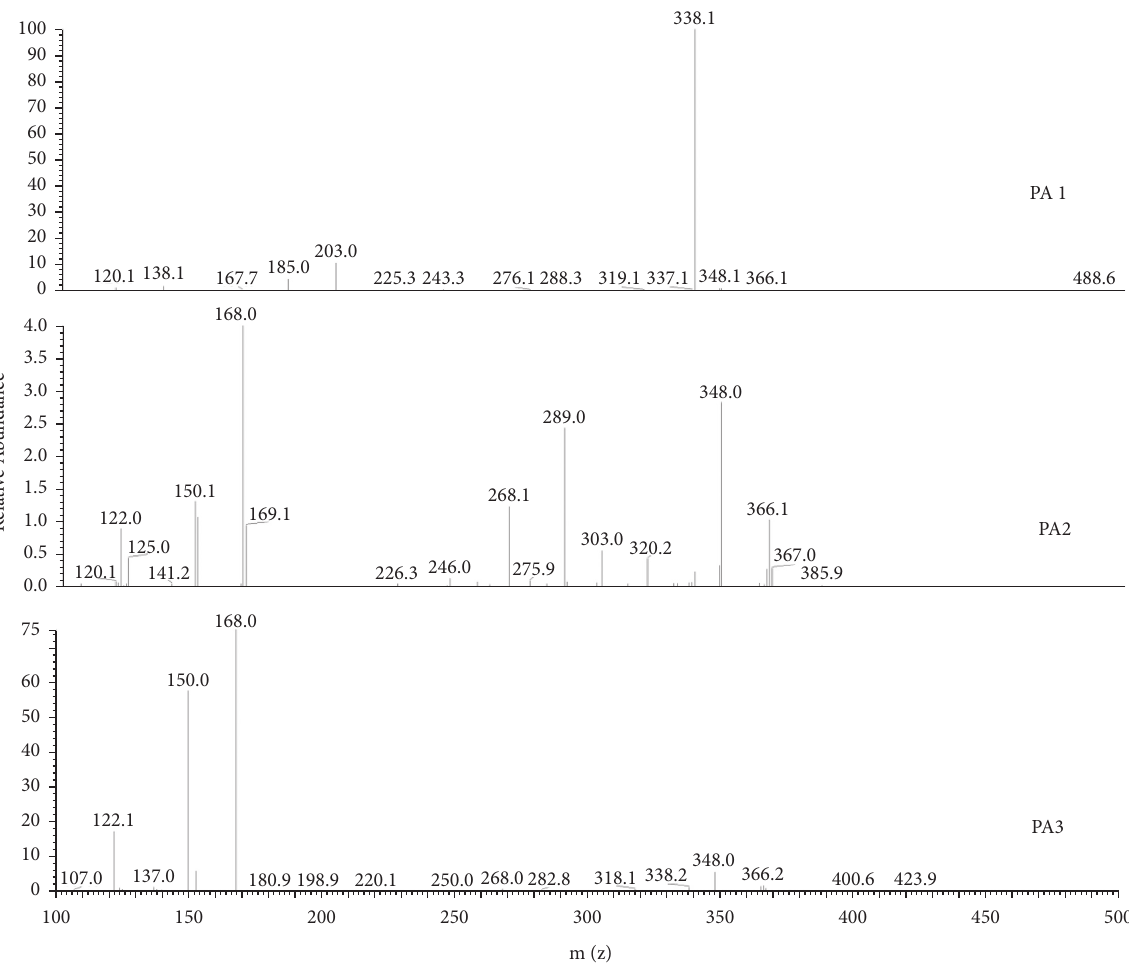
Figure 4: MS/MS spectrum of PA1, PA2, and